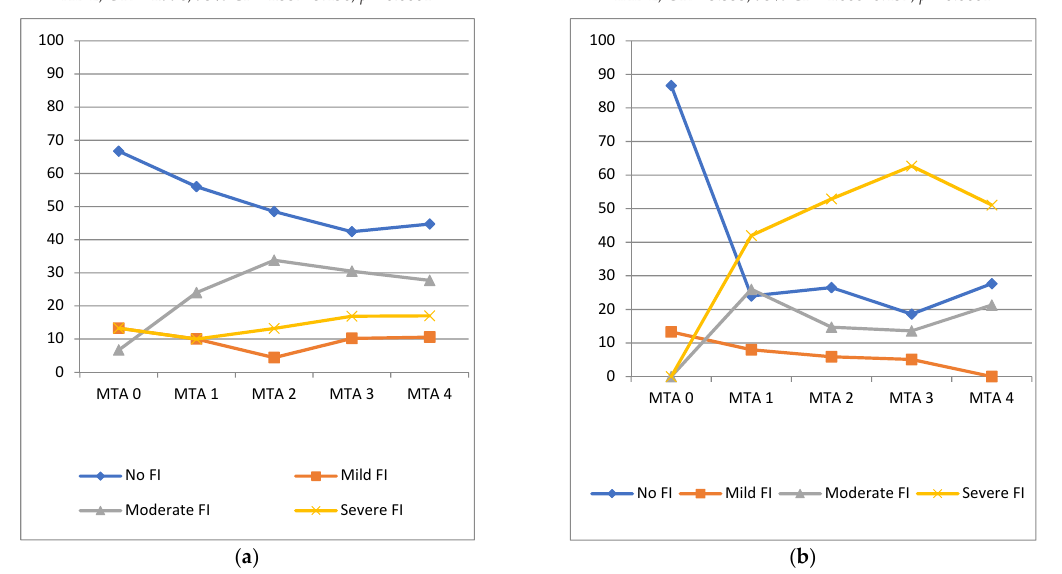
Figure 3. Distribution of MTA score according to the functional impairment (FI) severity evaluated by Activity of Daily Living ( a ) and Instrumental Activity of Daily Living ( b ). Legend: MTA , Medial Temporal Lobe Atrophy; ADL , Activities of Daily Living; IADL , Instrumental Activities of Daily Living. In Table 2, the association of the MTA score and NPI domains, adjusted by cognitive impairment presence/absence and severity, is shown. Depression and anxiety increased according to the MTA severity (NPI-Depression, OR = 4.869; 95% CI = 3.053-6.686; p < 0.0001 and NPI-Anxiety, OR = 2.792; 95% CI = 1.120–4.464; p = 0.001), while the other NPI domains did not show significant differences. Table 2. Association of MTA score and NPI domains, adjusted by cognitive impairment pres- ence/absence and severity. MTA 0 n = 15